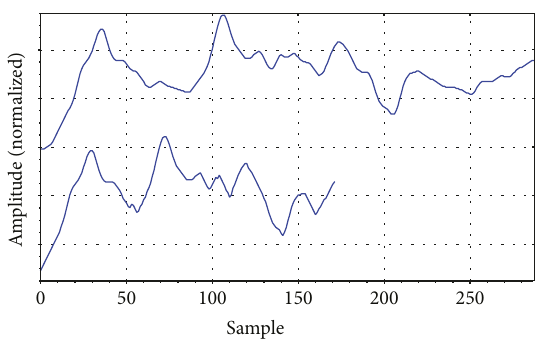
Figure 7: Example of trace segmentation application to a CGM record. Top: original record. Bottom: resampled record (60% of original